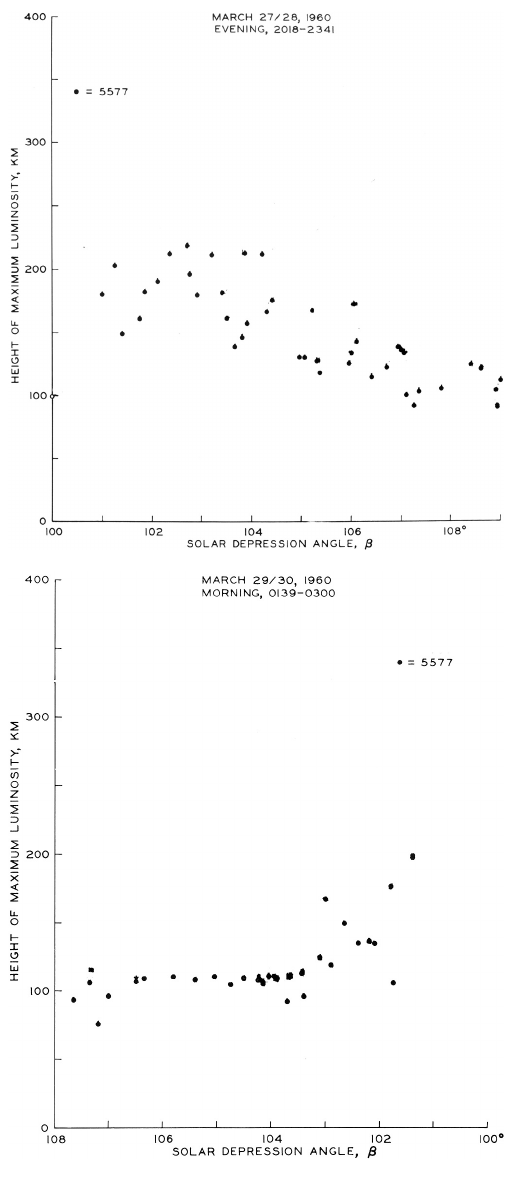
Fig. 4. ( a ) The height of maximum brightness of 5577 ˚A [OI] emis- sion as a function of solar depression angle for the evening twilight at College Alaska on 27 March 1960 (20:18–23:41 150 ◦ WMT). ( b ) Same as Fig. 4a, except for morning twilight, 30 March 1960 (01:39–03:00, 150 ◦ WMT)